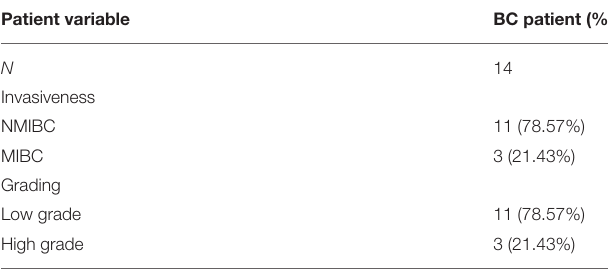
TABLE 1 | Clinicopathological features of patients included in this study. Patient